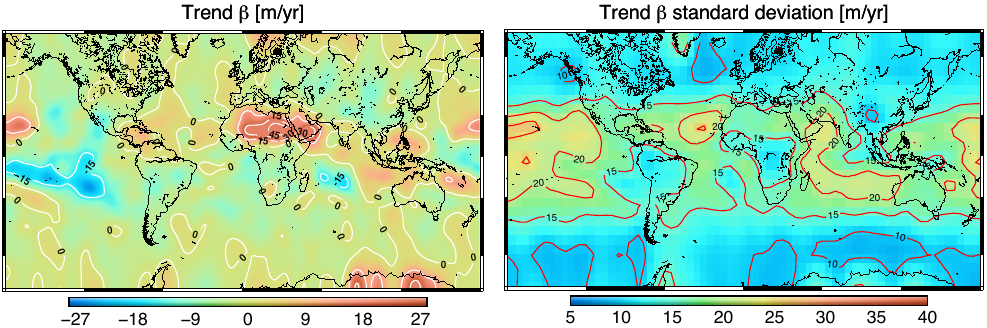
Figure 12. Global map of linear trend β in CTH (left) and standard deviation σ β (right). Figure 6.9: (a) Global trend β [ m / year ] in cloud top height anomaly. (b) Global trend standard deviation σ β [ m / year ] derived from 100-times bootstrapped normalized distributions, as in Fig. 6.6, for each 5 ◦ -sided grid cell. Both plots are smoothed with values from 8 surrounding cells. Table 4. Overview of zonal trends in CTH [myr − 1 ], ENSO excluded, masking any data within the box 170–120 ◦ W, 5 ◦ N–5 ◦ S. Bootstrap resamples n = 10 3 . The zonal values are not weighted by the respective land and water abundances. Belt Land + water Land Water With ENSO Tropics 5 ◦ N–5 ◦ S